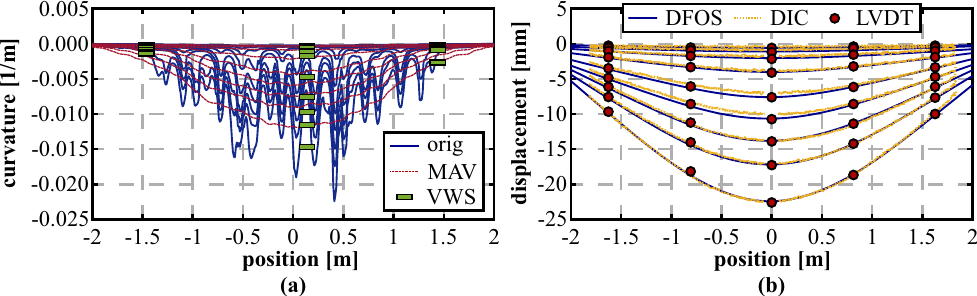
Figure 18. Vertical loading from 50 kN to 450 kN (steps of 50 kN): ( a ) Curvature profiles derived from DFOS strains and VWS readings. ( b ) Displacement curves calculated from DFOS strains and DIC compared to pointwise LVDT